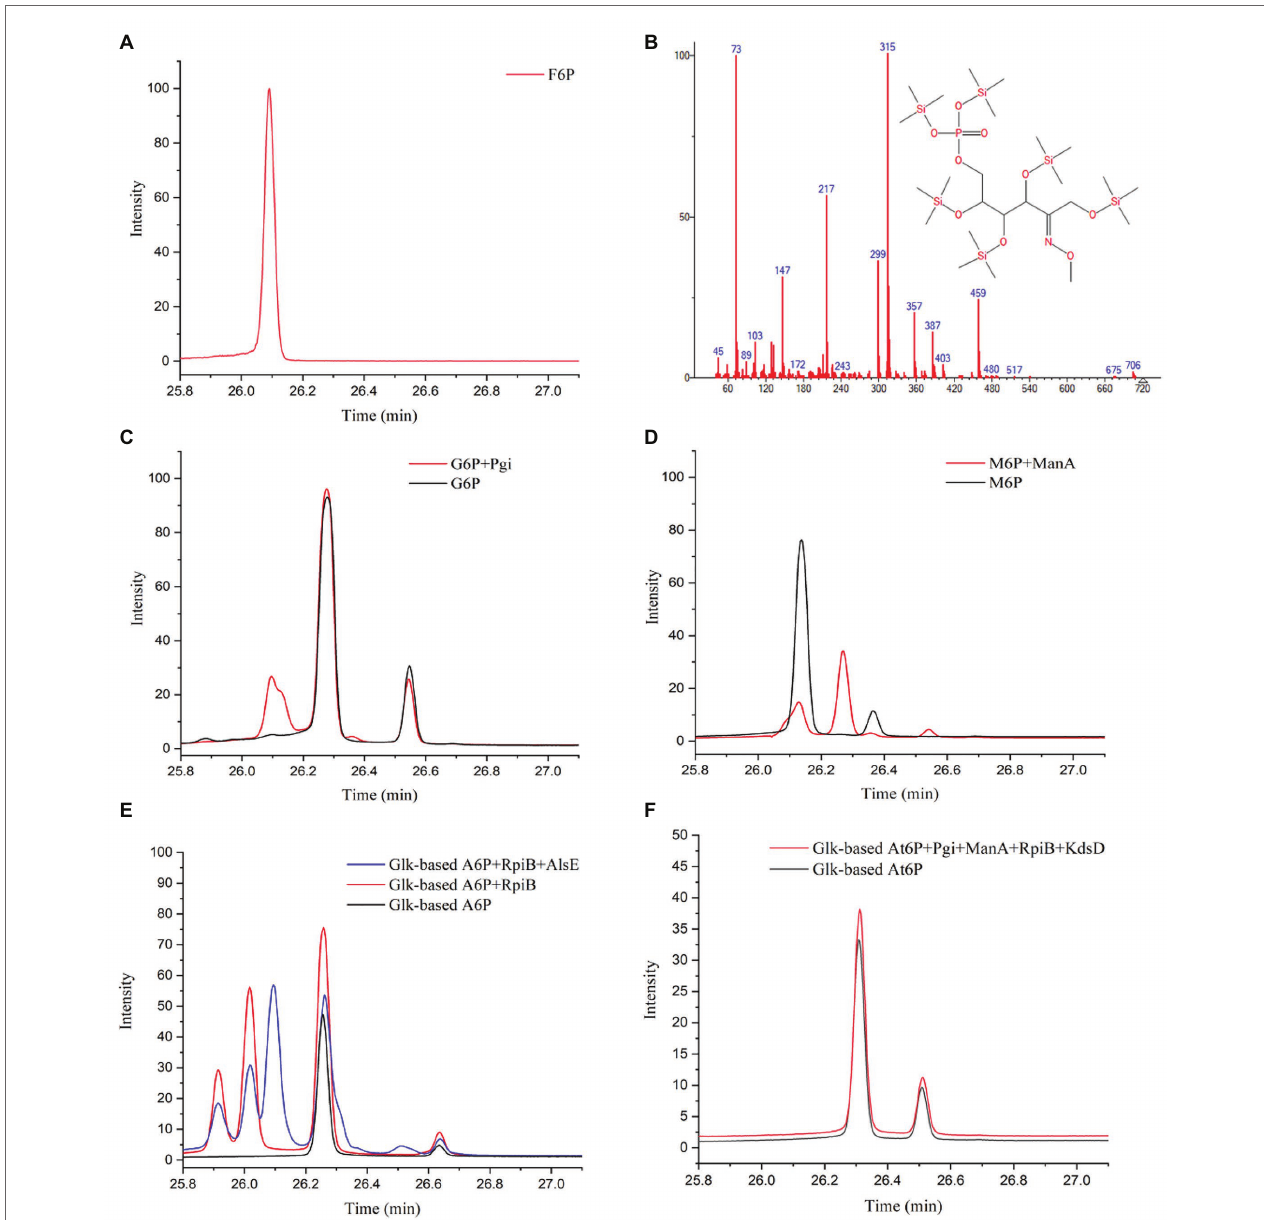
FIGURE 6 | Identification of isomerized products from aldohexose 6-phosphates by GC-TOFMS method. (A) F6P standard. (B) Fragment distributions of ketohexose 6-phosphates produced via the isomerization of G6P, M6P, or A6P with retention times of 25.915, 26.018, and 26.094 min. (C) G6P standard and product from G6P catalyzed by Pgi. (D) M6P standard and product from M6P catalyzed by ManA. (E) Glk-based A6P and product from A6P catalyzed by RpiB (and AlsE). (F) Glk-based At6P and product from At6P catalyzed by Pgi, ManA, RpiB, and